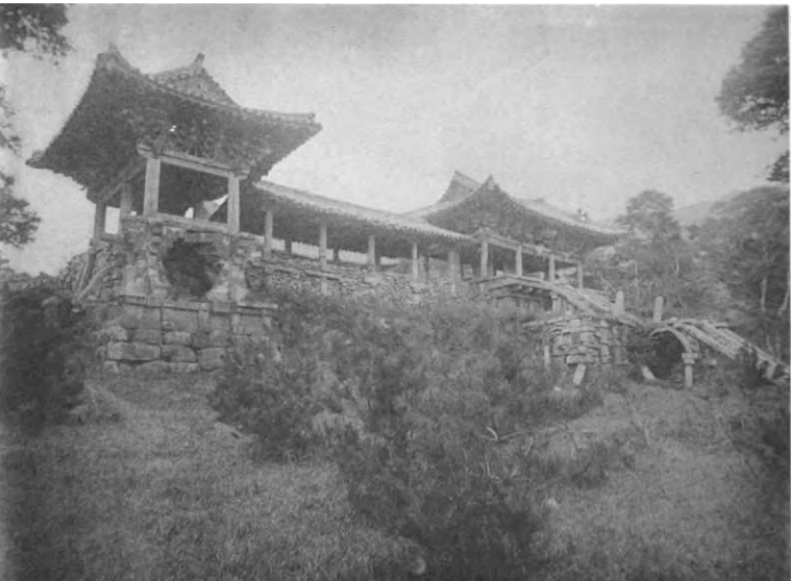
Figure 18. Sekino’s photo on the Bulguksa Monastery’s Front Buildings (Tokyoteikokudaigaku Kokadaigaku 1904).